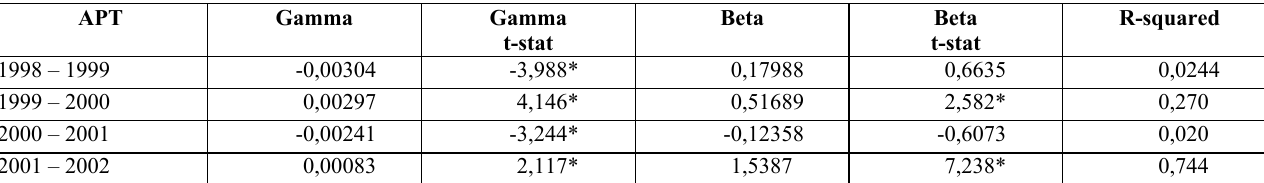
Table 5: Persistence in Performance Predicted by the APT Model’s Alpha Values